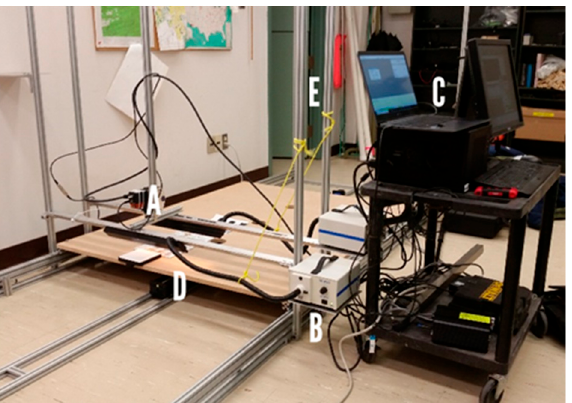
Figure 2. Close-range hyperspectral imaging platform. ( A ) Headwall imager, ( B ) light sources, ( C ) data processing unit, ( D ) linear stage, ( E ) frame.